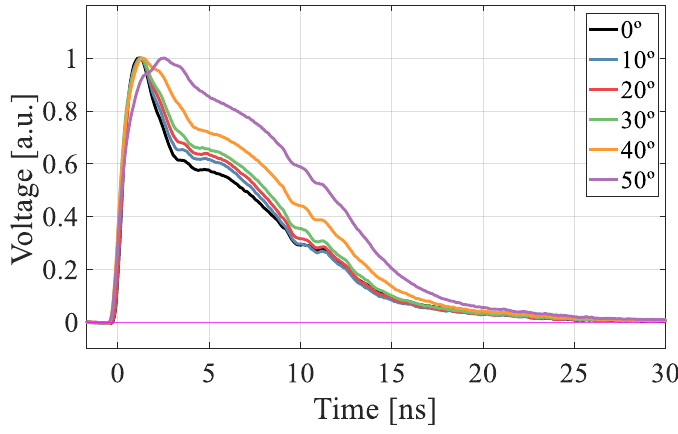
Figure 14. TRIBIC waveforms measured at 45 V for incidence angles from 0° to 50°.